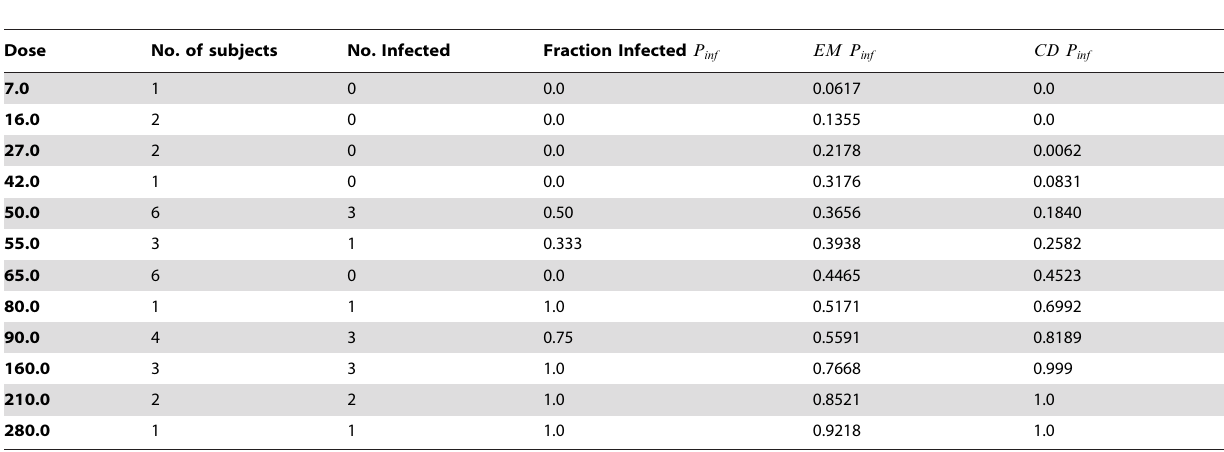
Table 1. Probability of infection from experimental data for Polivirus type 1 ( P inf ) compared to the probability of infection based on the Exponential model ( EM ) and the Cumulative Dose model ( CD